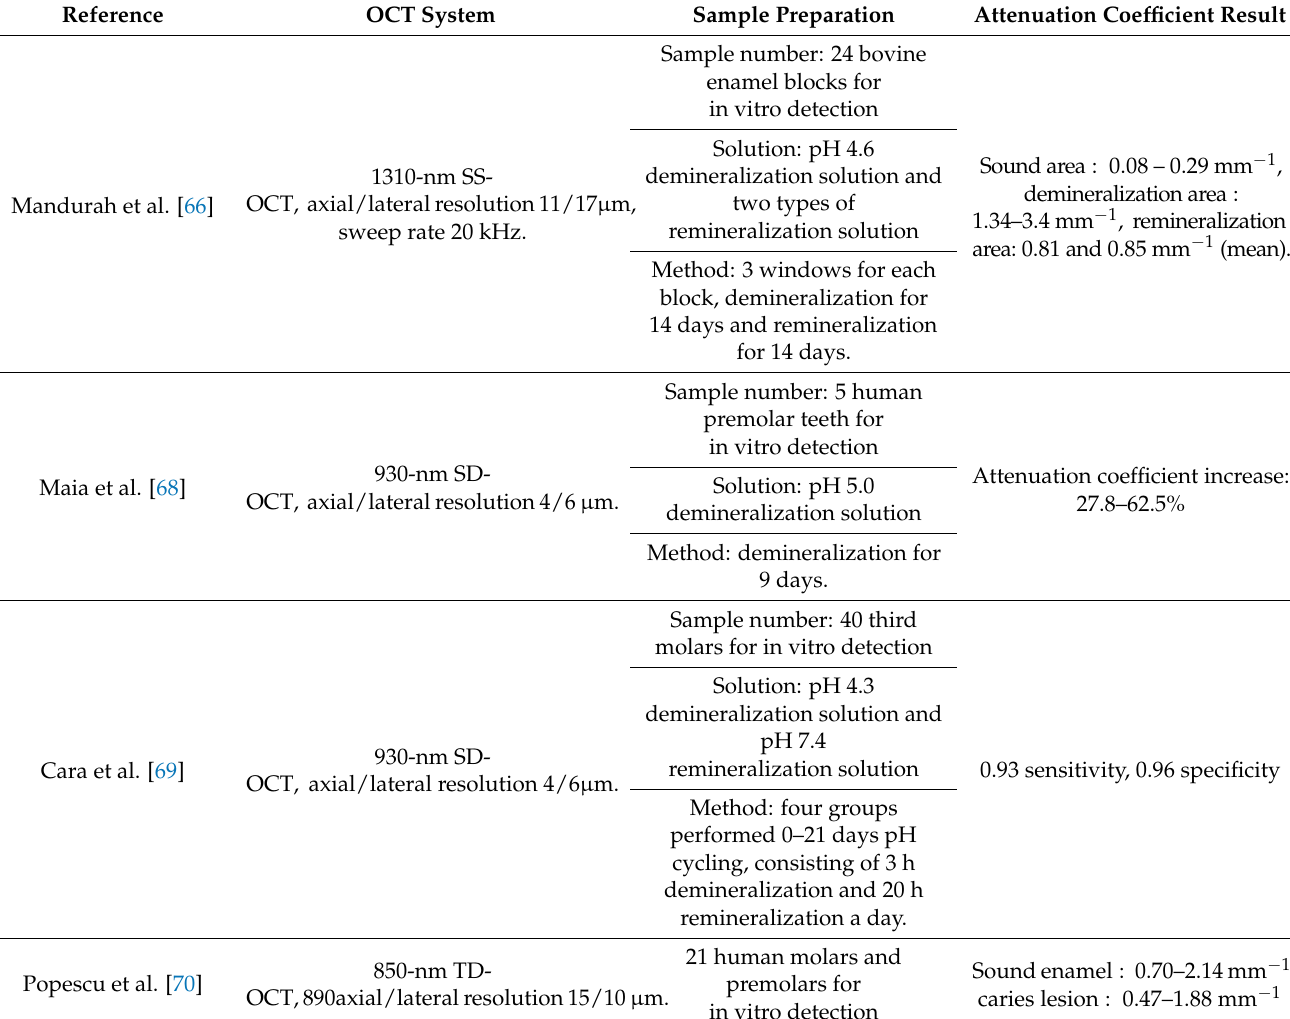
Table 3. Results of quantifying enamel caries with the attenuation